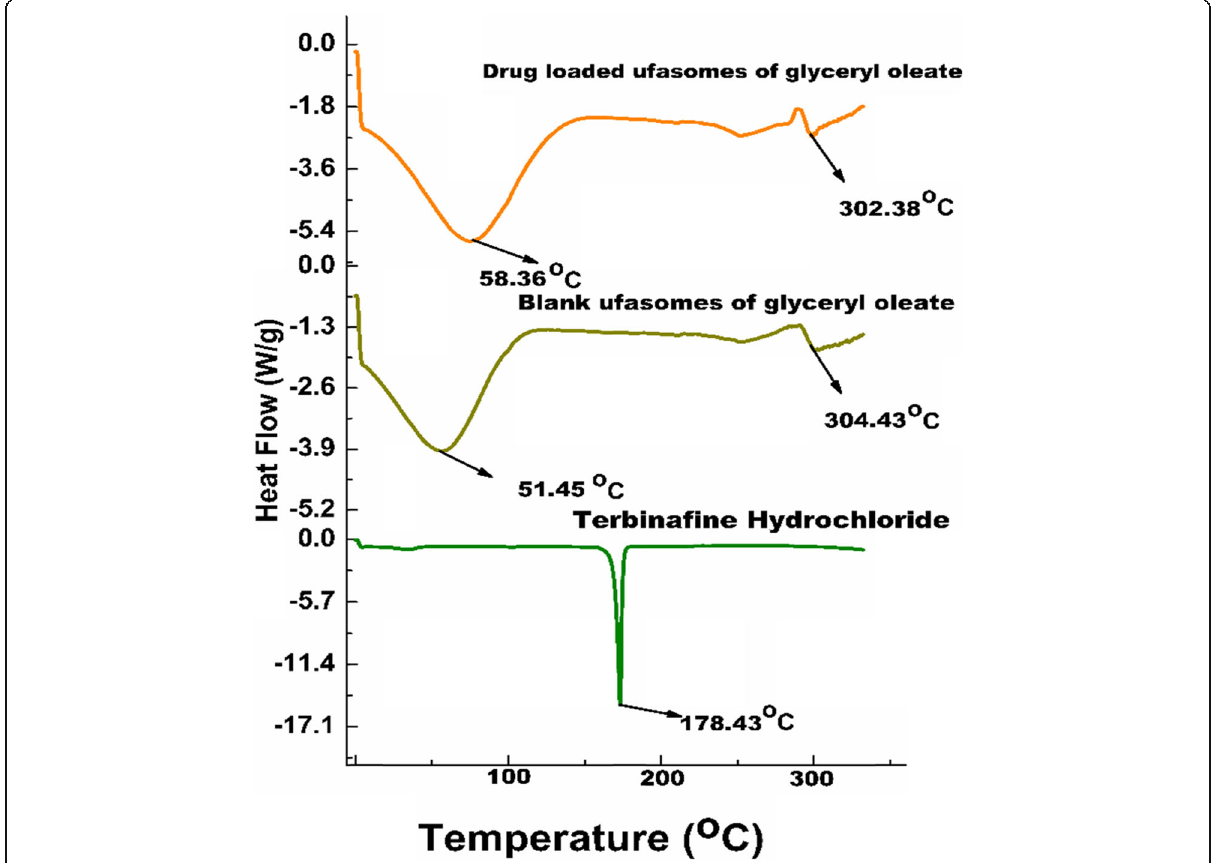
Fig. 3 DSC thermograph of terbinafine hydrochloride showing a sharp endothermic peak at 178.43 °C (reported melting point > 202 °C), indicating melting of the drug, in case of blank glyceryl oleate ufasomes, apart from the sharp melting point at 51.45 °C; a less intense peak was observed in 304.43 °C; however, no characteristic drug peak was observed in drug-loaded ufasomes of glyceryl oleate